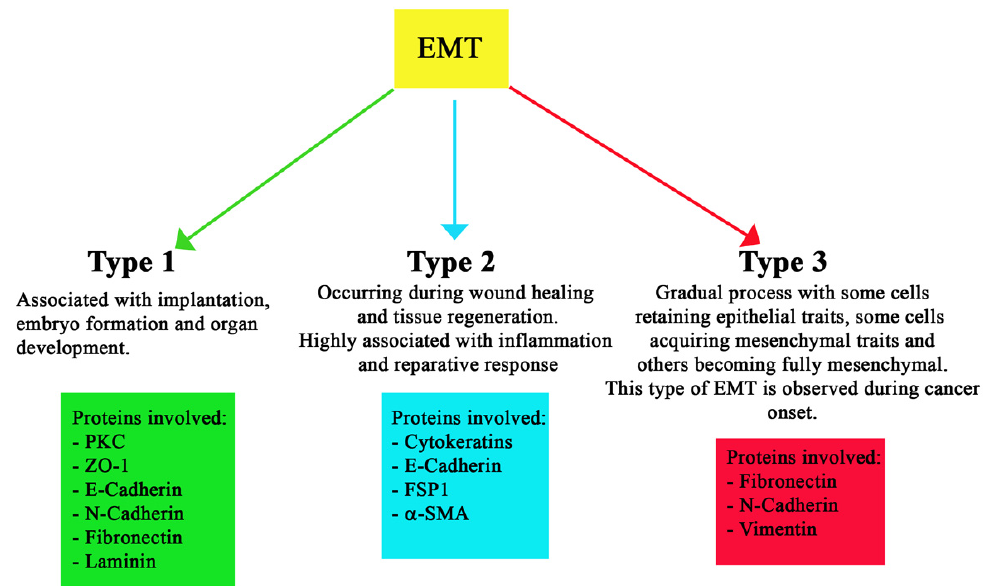
Figure 2. Schematic illustration of the types of EMT. EMT can be differentiated into three types, based on the biological process with which it is associated. Type 1 is mostly associated with development and is characterized by markers such as PKC, ZO-1, etc. [7,36–38]. Type 2 is associated with the inflammatory-reparative process, including wound healing, and mostly involves cytoskeletal markers, such as Cytokeratins [39,40]. Type 3 is a gradual process associated with the acquisition of mesenchymal traits in epithelial cells and is mostly involved in cancer development. Its markers are Fibronectin, Vimentin, etc. [41–44].